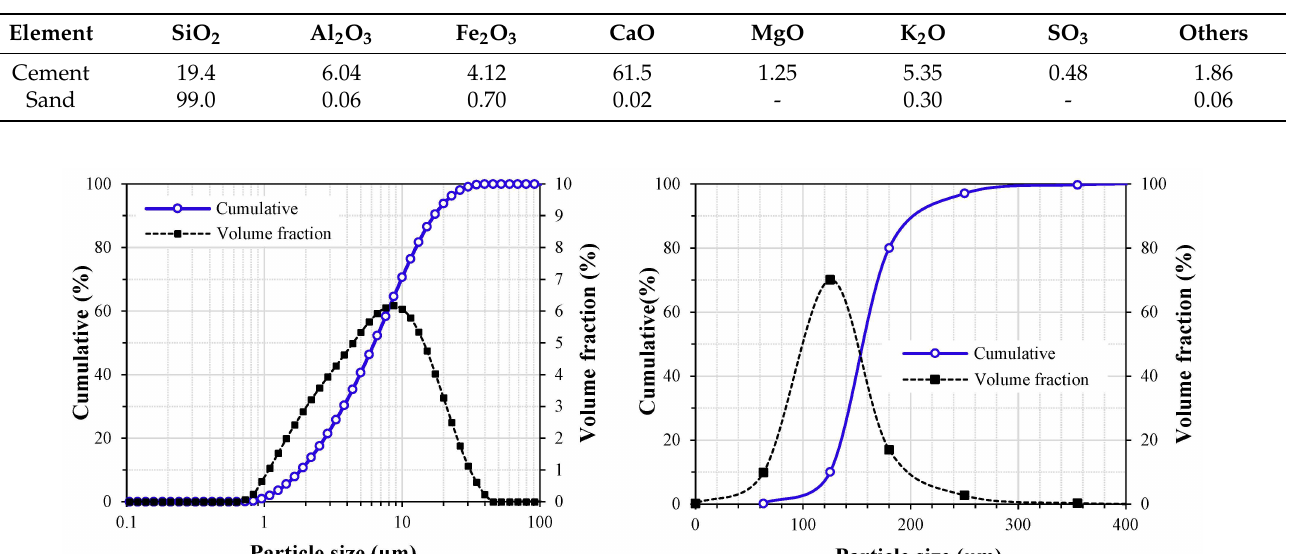
Table 1. Chemical composition of cement and sand (wt. %).